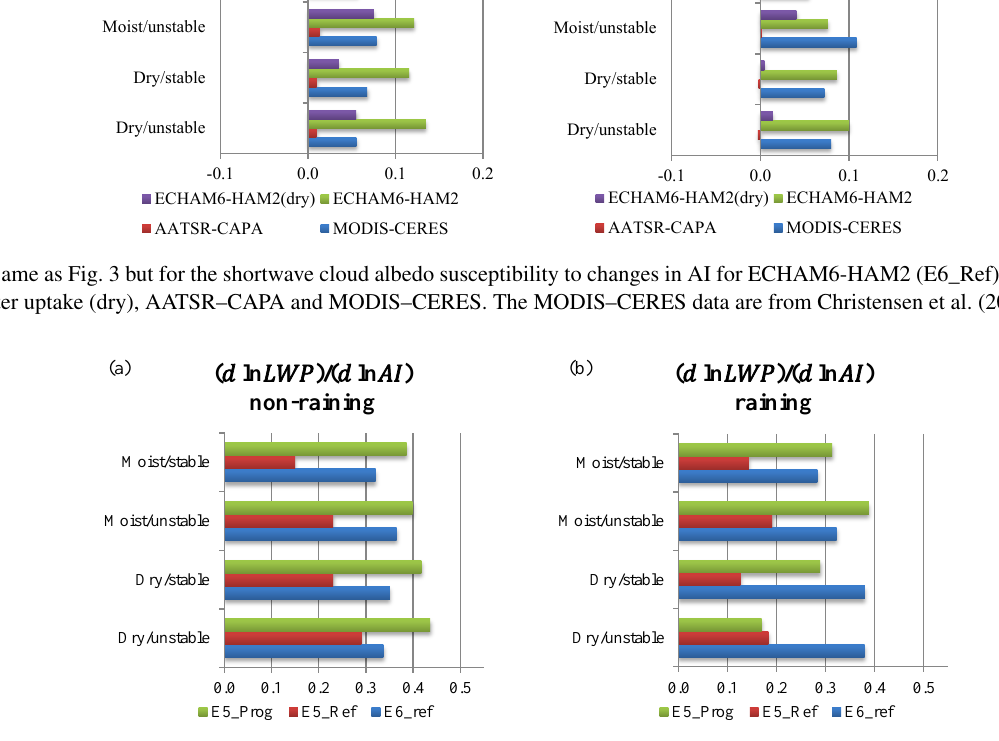
Figure 6. Same as Fig. 3 but for the LWP susceptibility to changes in AI for E5_Prog, E5_Ref and